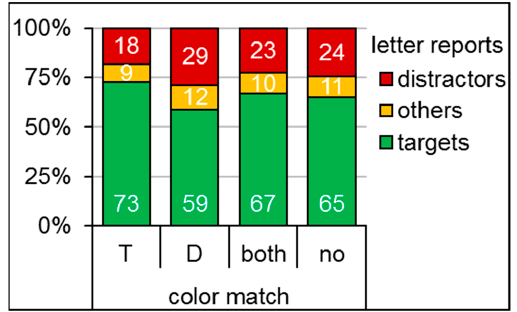
Figure 2. Mean percent of reported target ( green ), distractor ( red ), and other letters ( orange ) for the four color match conditions of Experiment 1: T = target color match, D = distractor color match, both = target and distractor color match, and no = no match of target and distractor to the cue’s color.